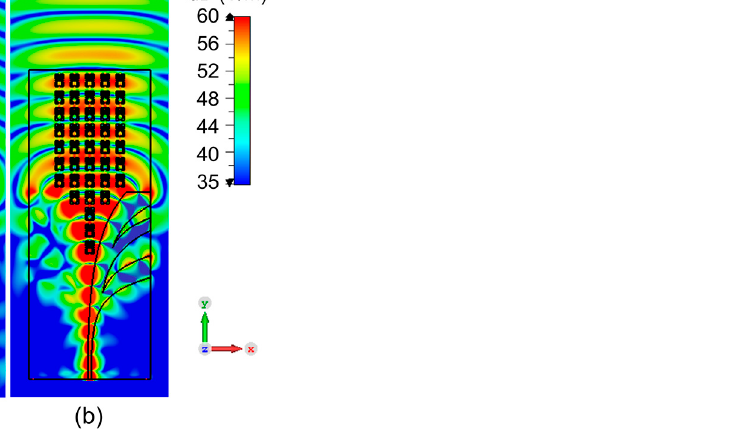
Figure 10. Full-wave simulation of the E-field distribution in xy -plane at f = 14 GHz of ( a ) AVA without metalens and ( b ) AVA-L-shaped#1.